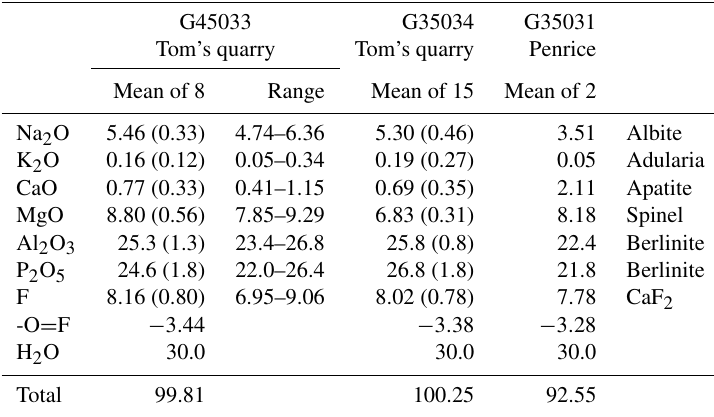
Table 1. Electron microprobe analyses, with standard deviations in brackets.